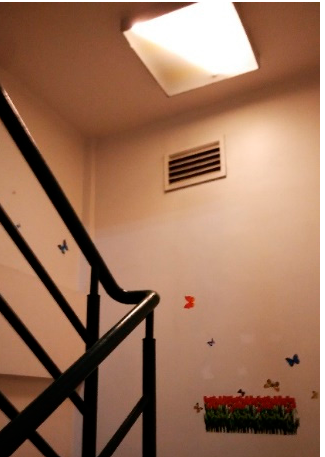
Figure 9. Lensed fluorescent troffer in Building B.